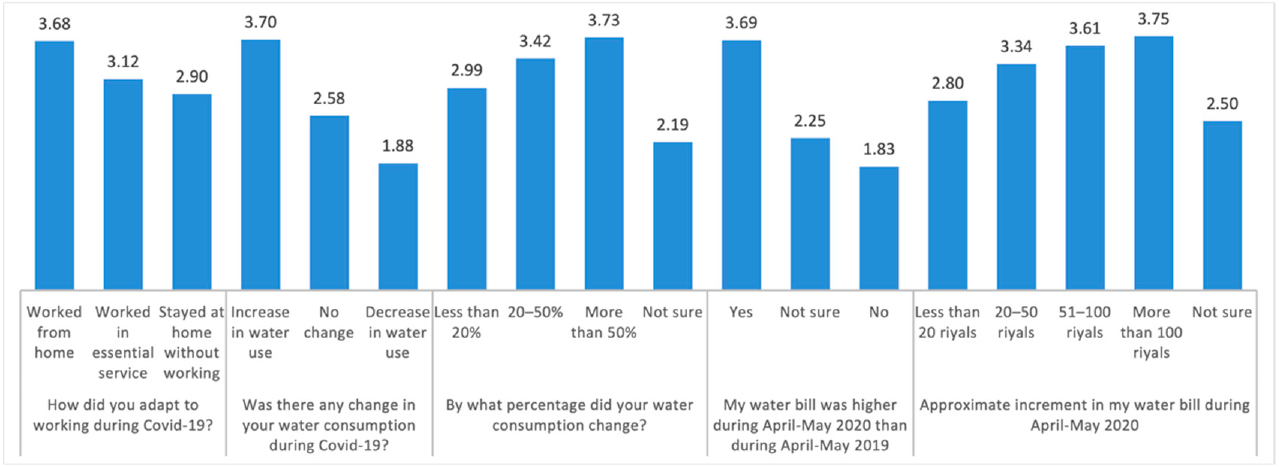
Figure 4. Changes in household water consumption.